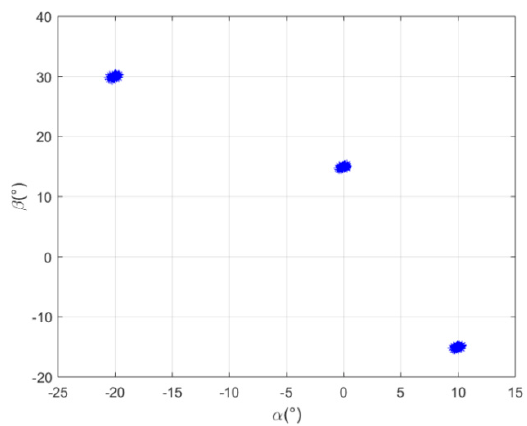
Figure 2. The estimated 2D DOAs. Table 1. Mean and RMSE of the gain-phase error coefficients.